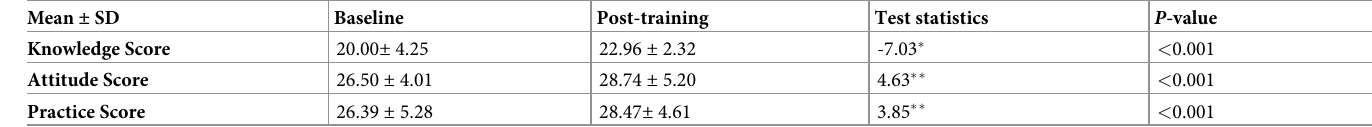
Table 8. Knowledge, attitude, and preventive practices of clients before and after interaction with trained PHC workers.